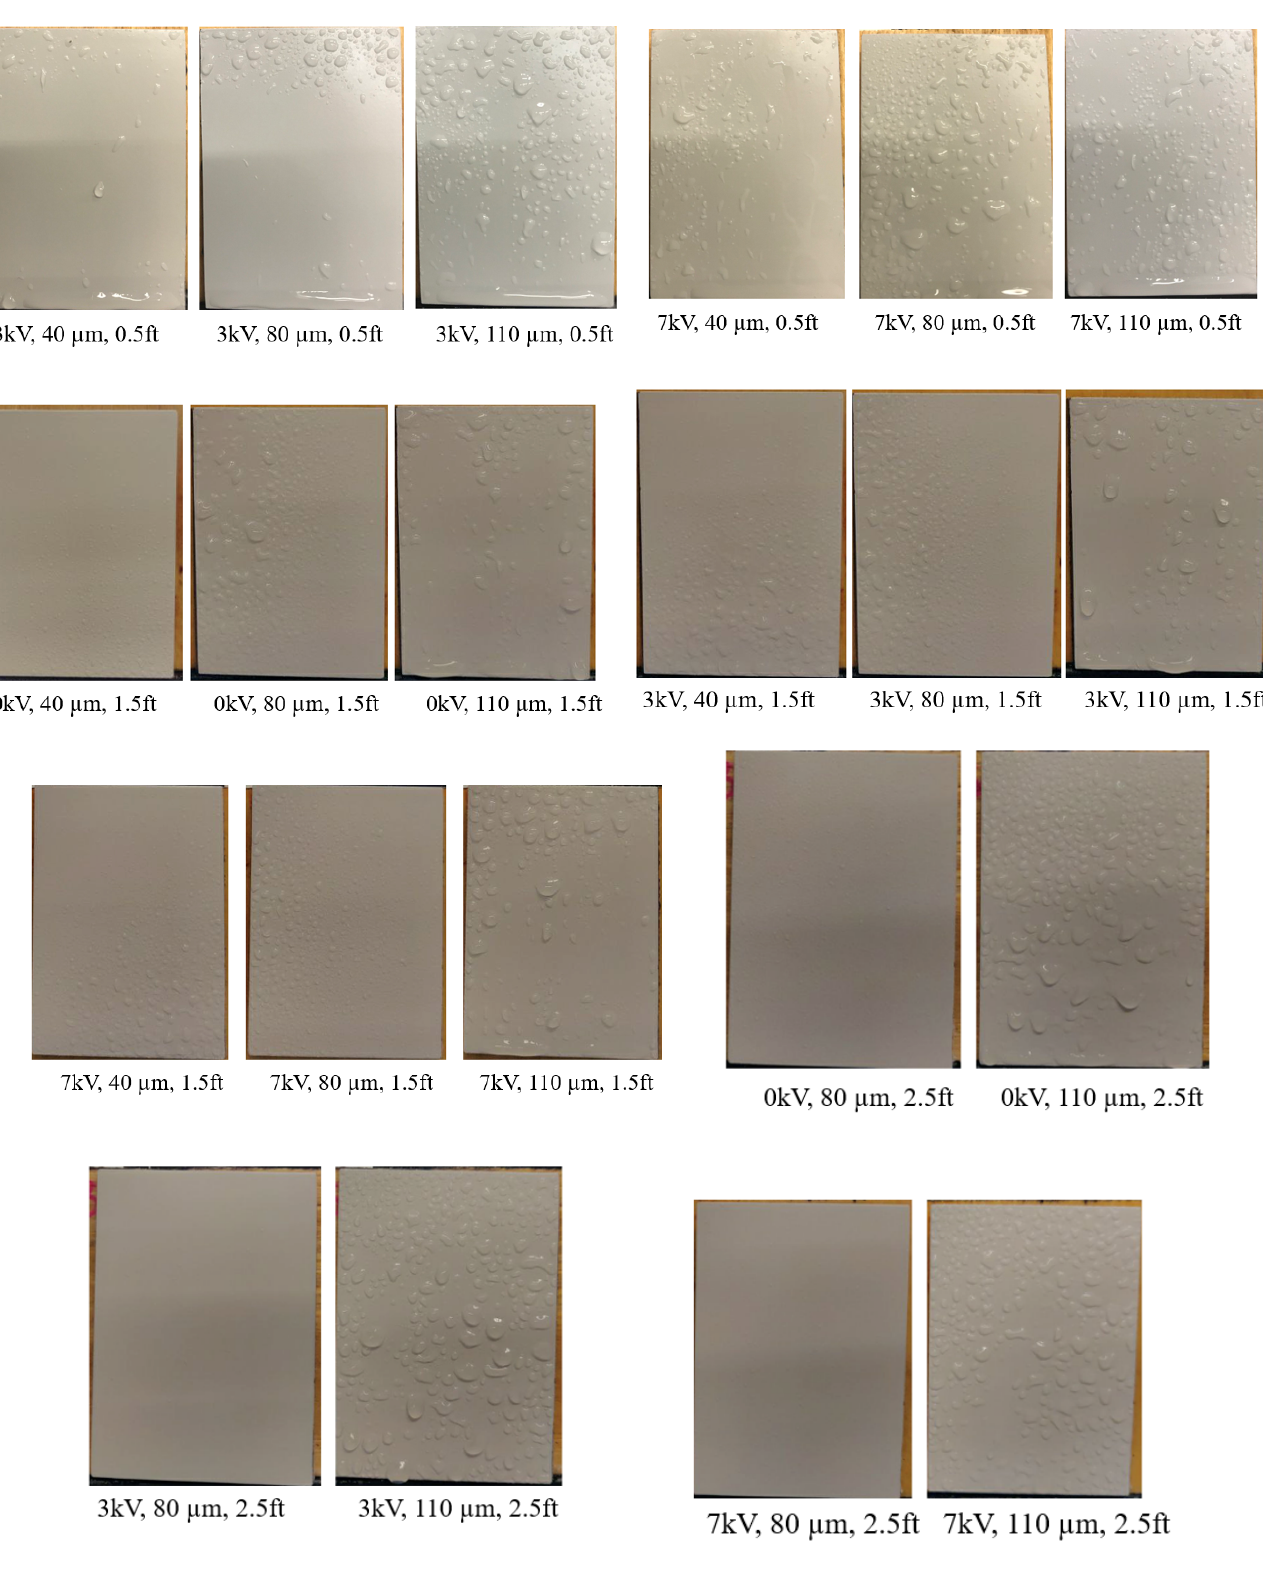
Figure A29. Aircraft sample-2: qualitative images of electrostatic deposition under various system